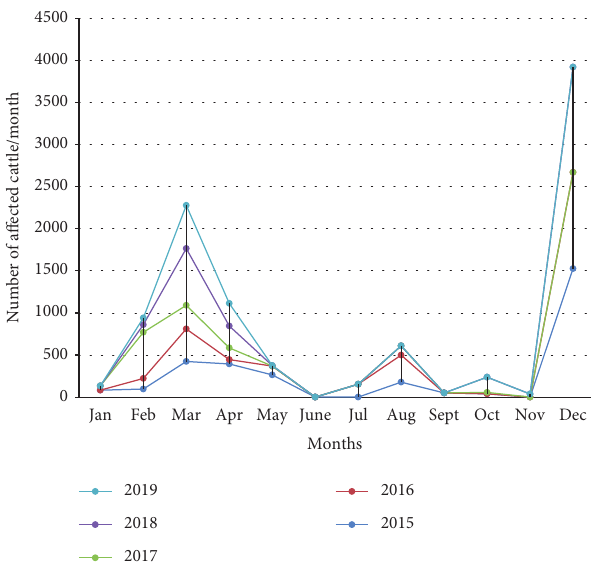
Figure 3: FMD-affected cattle in the Gairo district by the year (2015–2019).